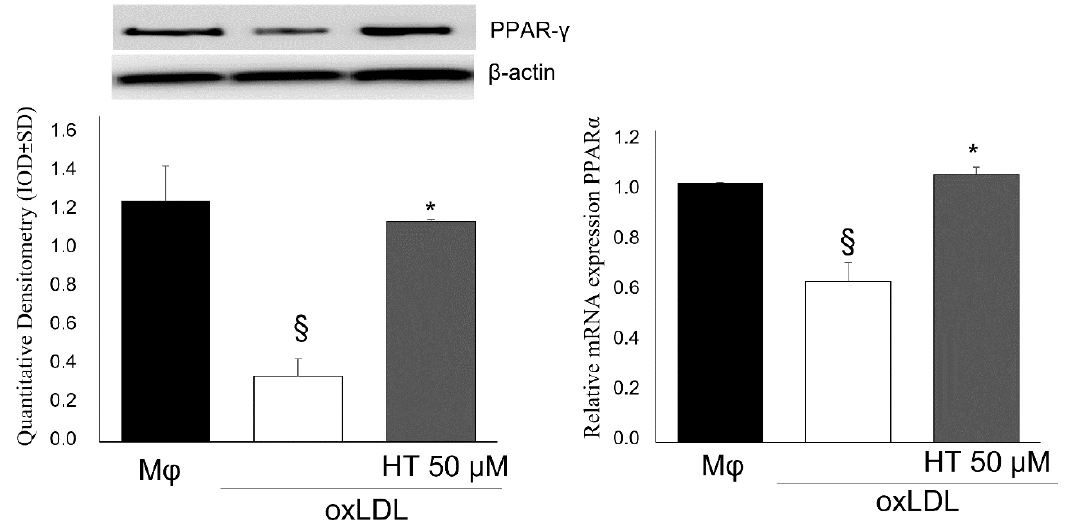
Figure 5. Effect of HT on PPAR γ expression in THP-1 macrophage foam cells. THP-1 macrophage- derived foam cells were treated with HT (50 µ M) for 24 h. Then, Western blot ( left ) and qPCR ( right ) analyses were performed. § p < 0.05 vs. macrophages (M φ ); * p < 0.05 vs. oxLDL ( n = 3). HT, hydroxytyrosol; oxLDL, oxidized low-density lipoprotein.